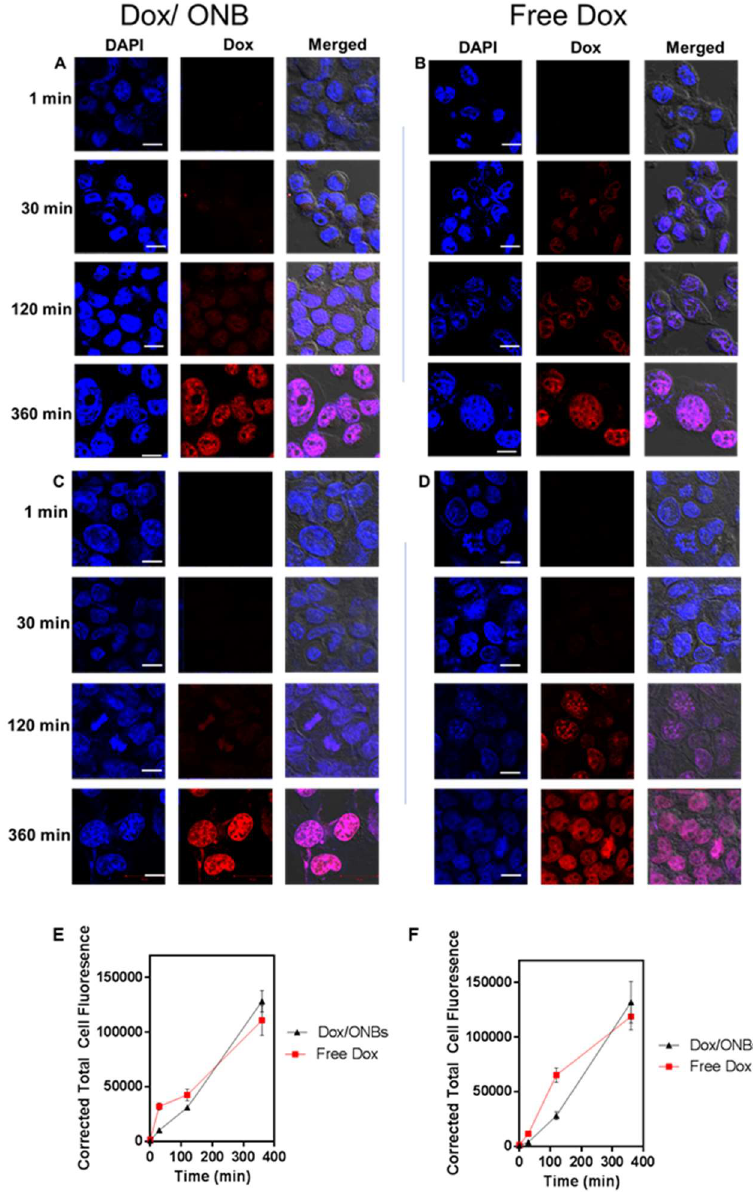
Figure 4. Intracellular confocal microscopy imaging of Dox penetration using Dox fluorescence and DAPI staining. Dox penetration in MDA-MB-231 cells using ( A ) Dox / ONB conjugates and ( B ) Free Dox. Scale bars = 10 µ m. Dox penetration in HeLa cells using ( C ) Dox / ONB and ( D ) Free Dox. Scale bars = 10 µ m. ( E ) Corrected total cell fluorescence intensity of Free Dox and Dox / ONBs for MDA-MB-231 cells from confocal images measured using ImageJ software. ( F ) Corrected total cell fluorescence intensity of free Dox and Dox / ONBs for HeLa cells from confocal images measured using ImageJ software.